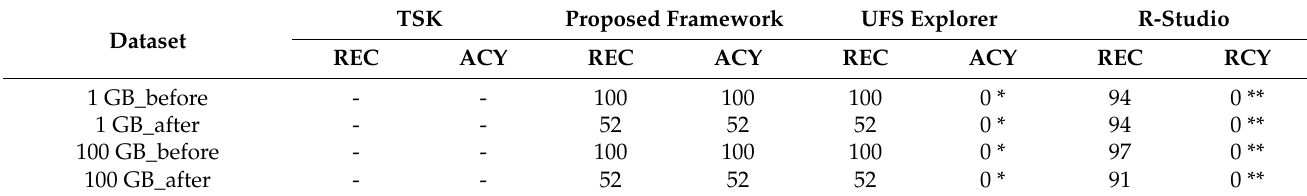
Table 5. Experimental result based on recovery rate and accuracy for